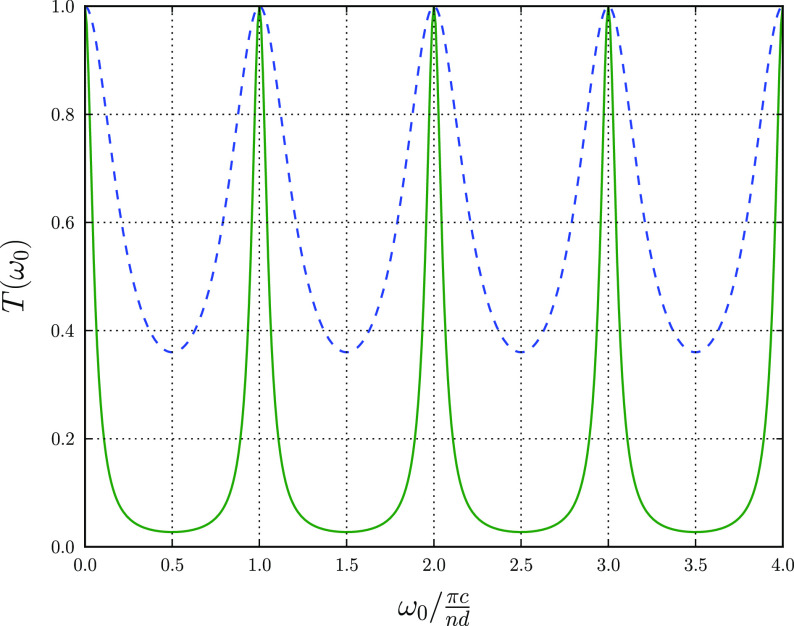
Transmission rate Tcav(ω0) in Equation (B.8) of a Fabry-Pérot cavity which is driven by monochromatic light of frequency ω0 for the refractive index n=3 (dashed line) and n=20 (solid line). (The colour version of this figure is included in the online version of the journal.)